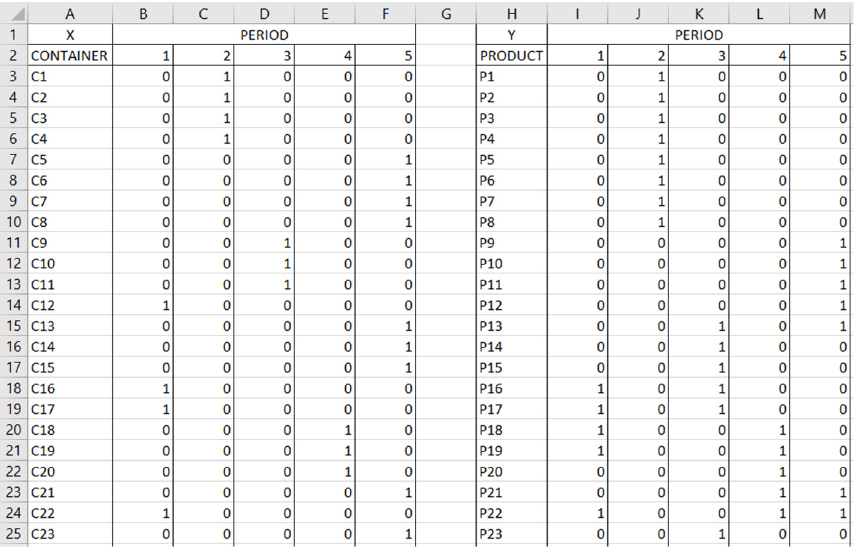
Figure 7. Output of decision variables x and y for Case 2 in the form of Excel spreadsheet. Table 2. Summary of the decision variables for Case